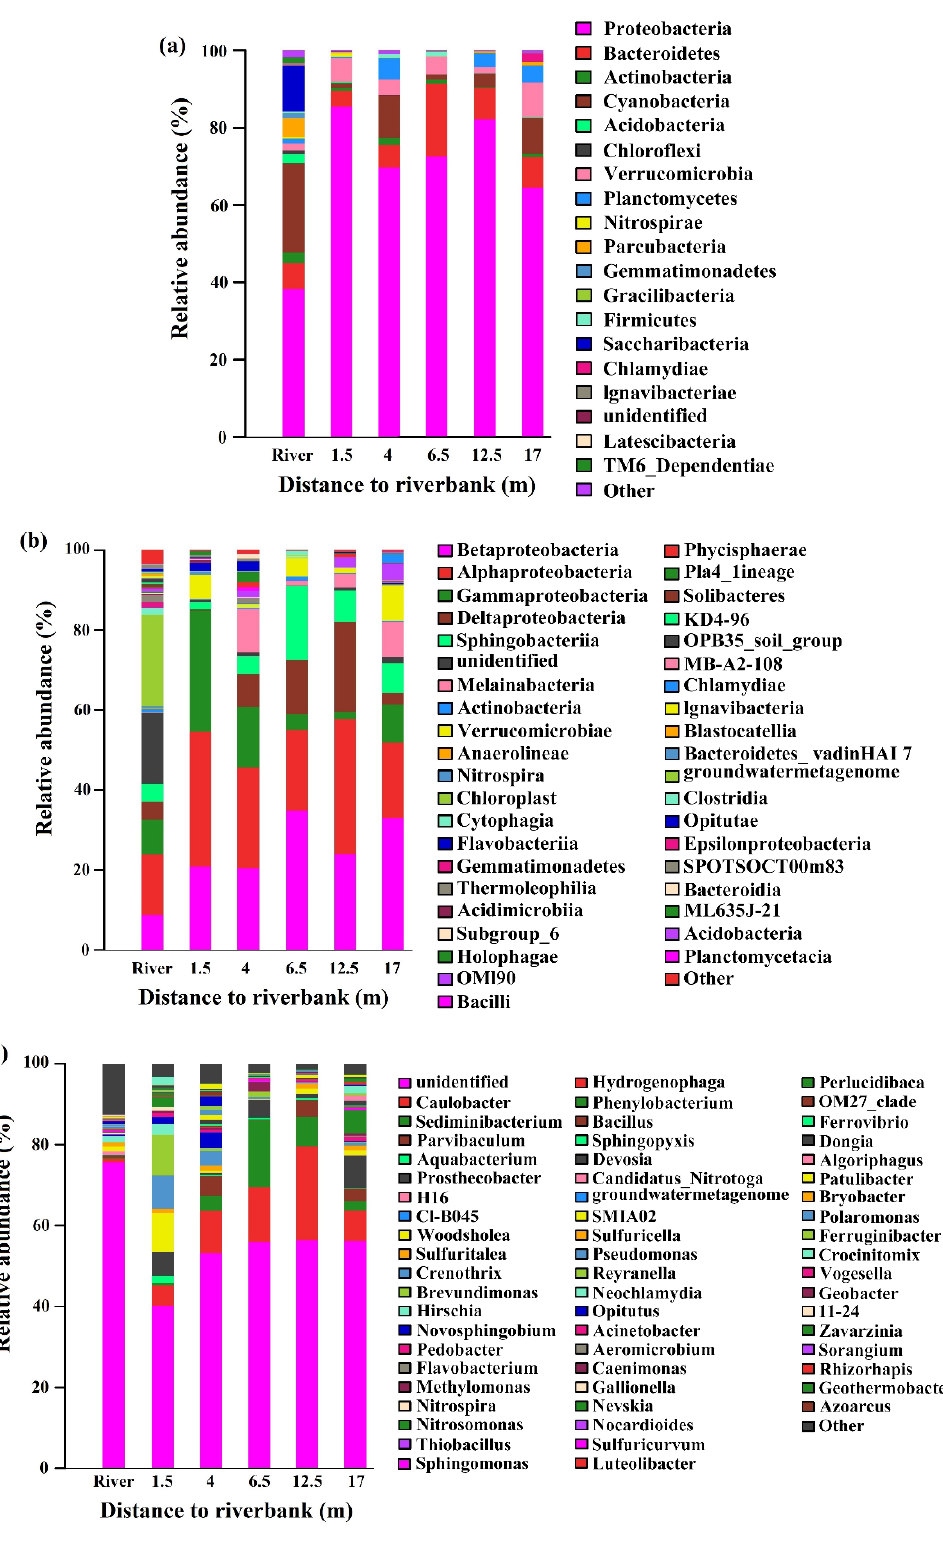
Figure 6. Microbial community composition: ( a ) phylum-level; ( b ) class-level; ( c ) genus-level (Other: the summation of the bacteria, of which the relative abundance was considerably below 2%). Alphaproteobacteria included Sphingomonas and Brevundimonas , which have the ability of arsenic reduction and iron reduction [47].